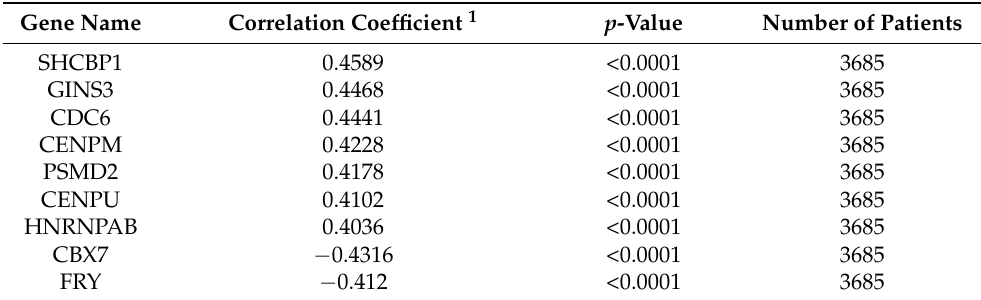
Table 1. Shows genes that correlate positively and negatively with TUBB in ER α -positive breast cancer patients.